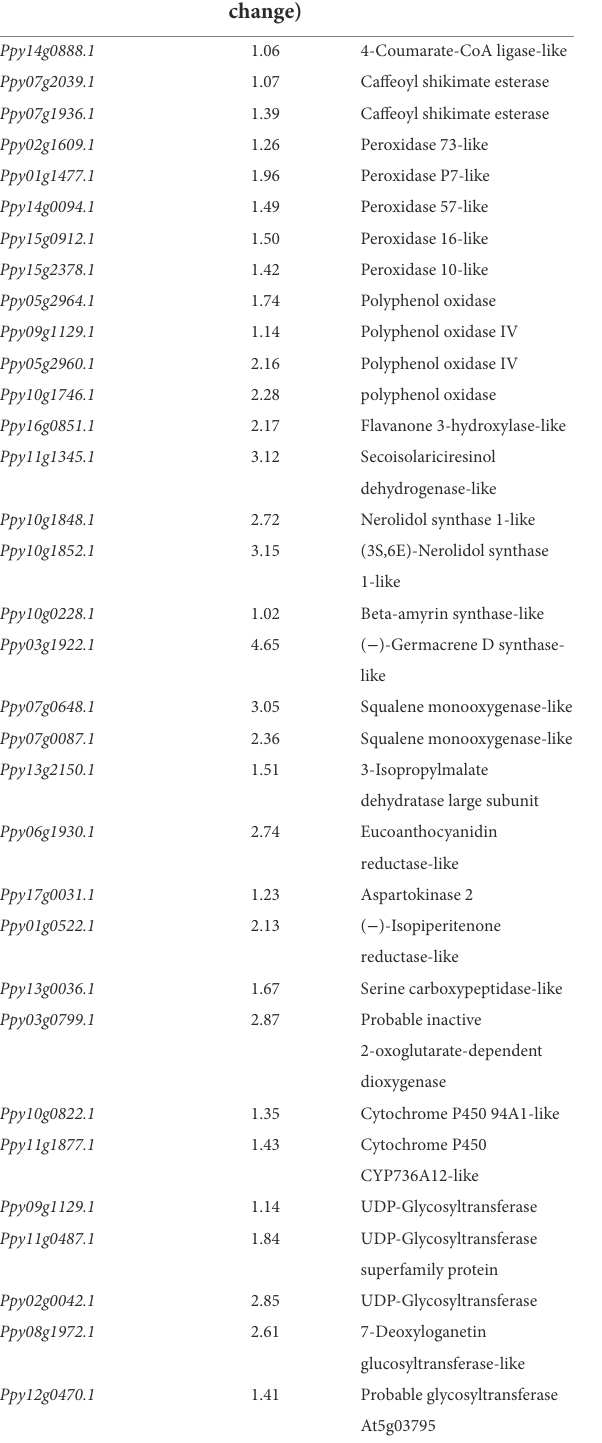
TABLE 2 List of upregulated gene related to secondary metabolism in TABLE 3 List of upregulated gene related to defense-related in pear twigs at the present of Paenibacillus polymyxa strain Nl4. Paenibacillus polymyxa strain Nl4 treated pear twigs. Gene log 2 (fold Description Gene log 2 (fold change) Description change)